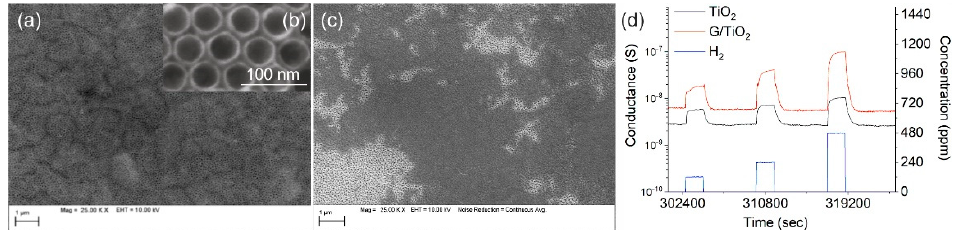
Figure 1. ( a , b ) SEM images of the TNTs, ( c ) SEM micrograph of the composite (G/TiO 2 ), ( d ) dynamical response of the composite (G/TiO 2 ) and pure TNTs towards 120, 240 and 480 ppm of H 2 at 300